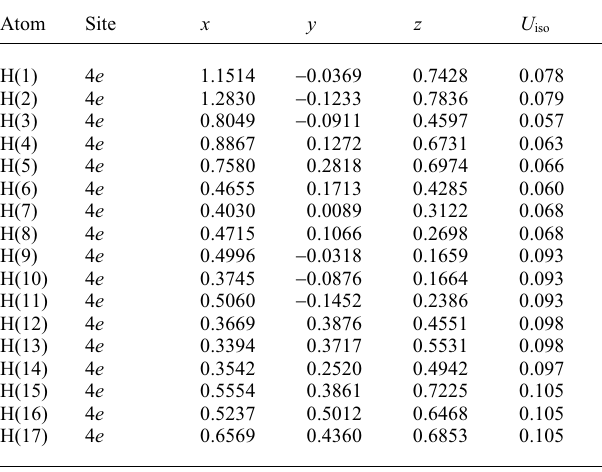
Table 2. Atomic coordinates and displacement parameters (in Å 2 )